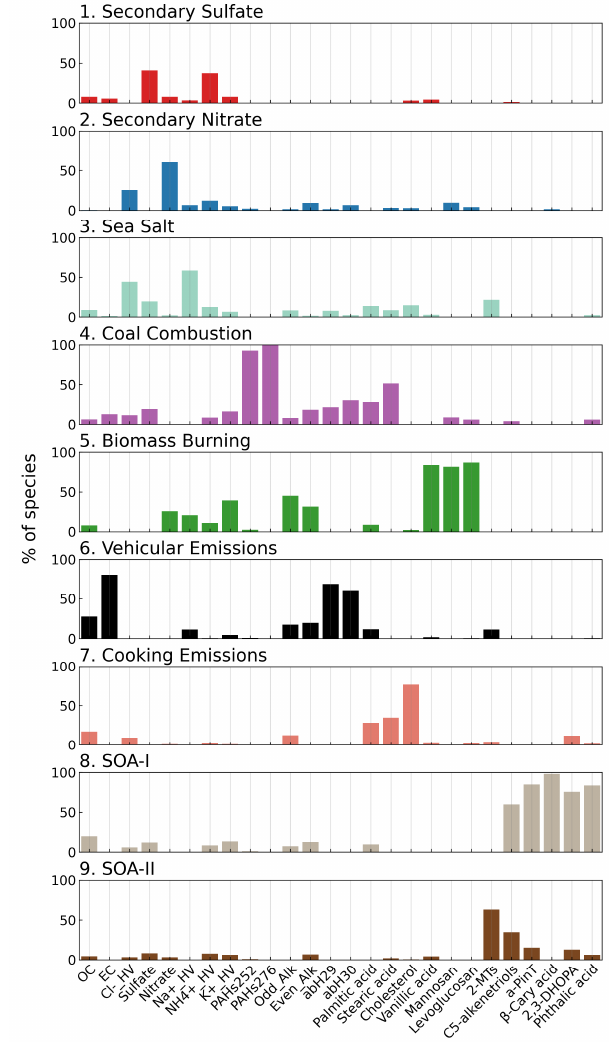
Figure 8. Constrained factor profiles of 9-factor solutions applying data from YL winter and MK ambient particulate matter (PM 2.5 ) filter samples (PMF CholC16C18 ). Varying error fraction (EF) was applied to cholesterol where a = 0.1.